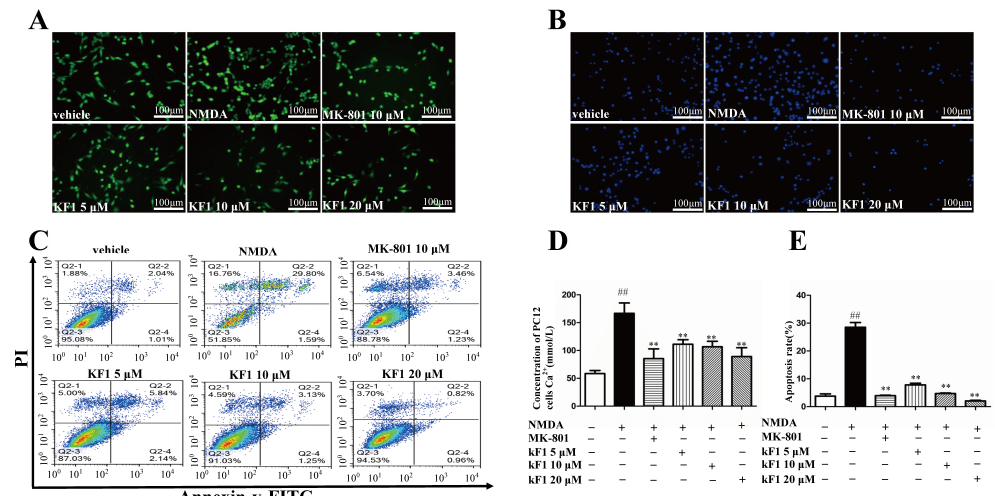
Figure 2. Effects of KF1 on NMDA-induced neurotoxicity in PC12 cells. ( A ) Fluorescence images of intracellular calcium in different groups. ( B ) Representative fluorescence images of Hoechst 33342 staining. ( C ) Effects of KF1 on NMDA-induced early and late apoptosis after AV/PI double staining. ( D ) Effect of KF1 on NMDA-induced Ca 2+ increase in PC12 cells. ( E ) The quantitative analysis of early and late apoptotic cells. Bars: 100 μ m, the data represent mean ± SEM ( n = 5). ## p < 0.01 versus vehicle group; ** p < 0.01 versus NMDA group.